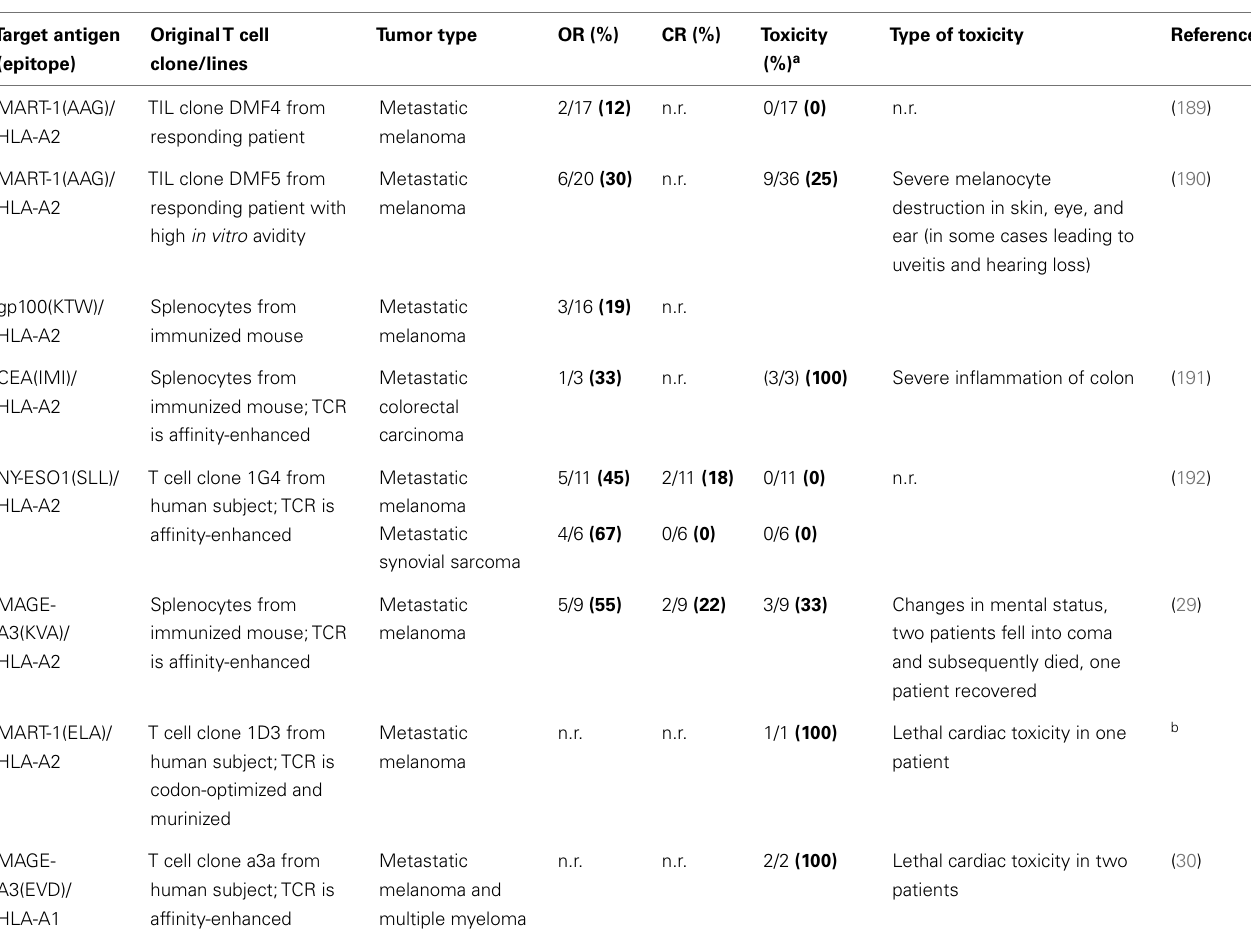
Table 2 |T cell receptor gene therapy trials – an update on efficacy and